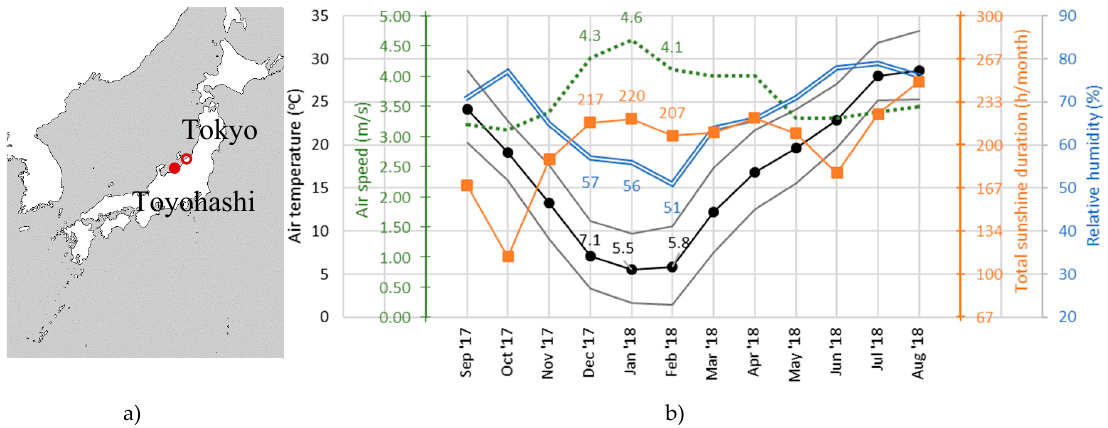
Figure 1. Toyohashi, Japan. ( a ) Location; ( b ) climate. Data from JMA WMO ID: 47654—min, max and mean air temperature and relative humidity for winter season 2017–2018.